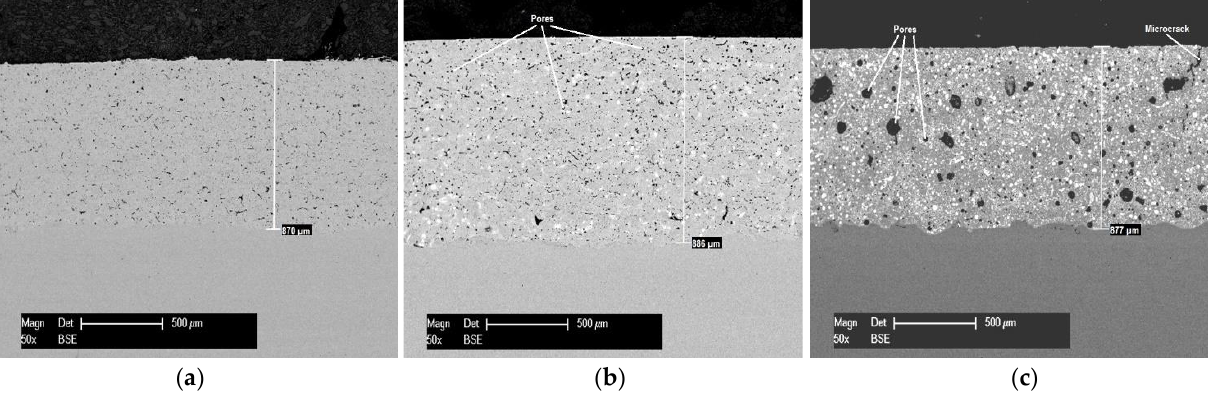
Figure 2. Cross-section SEM micrographs of the coatings: ( a ) SFA; ( b ) 85/15; ( c ) 70/30.